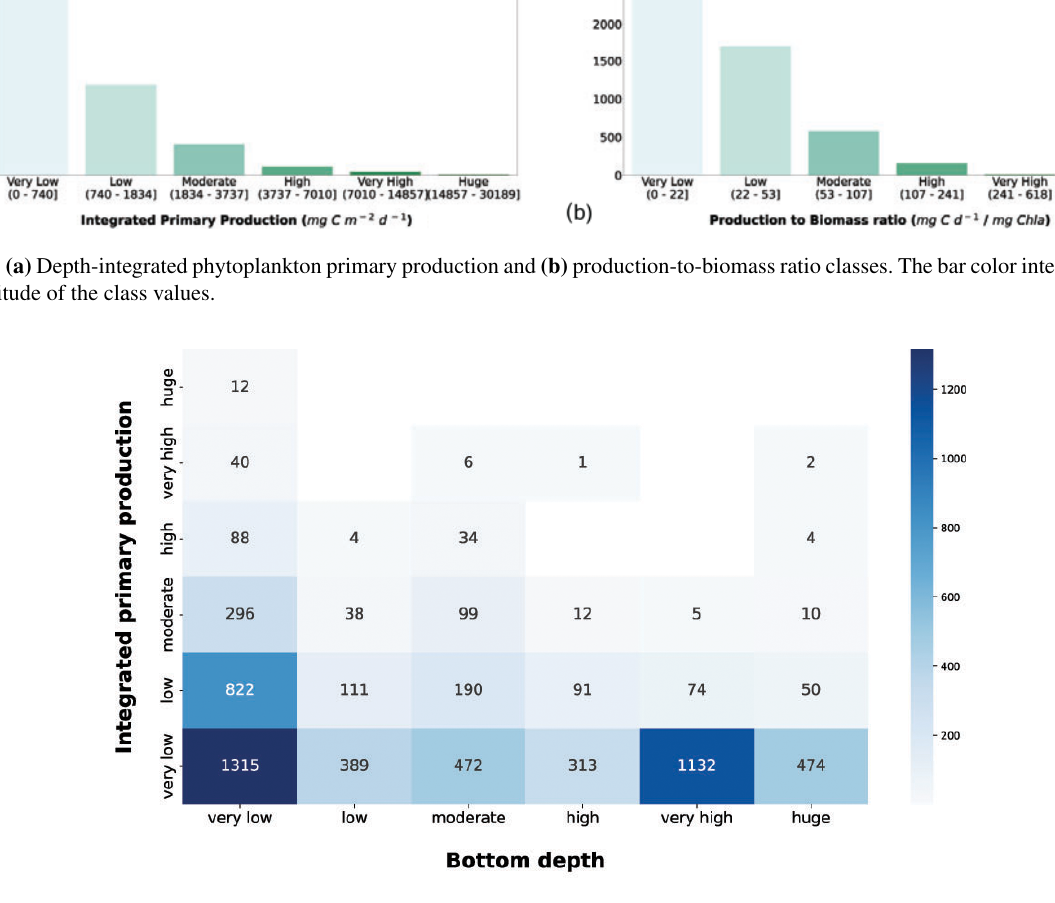
Figure 9. IPP vs. bottom depth. The blue heatmap highlight the difference in production potential between coastal and open-ocean